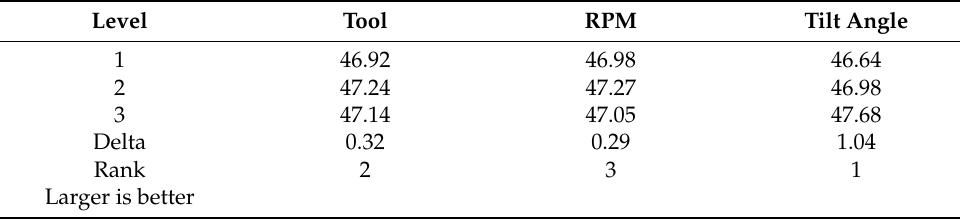
Table 10. Response table for signal-to-noise